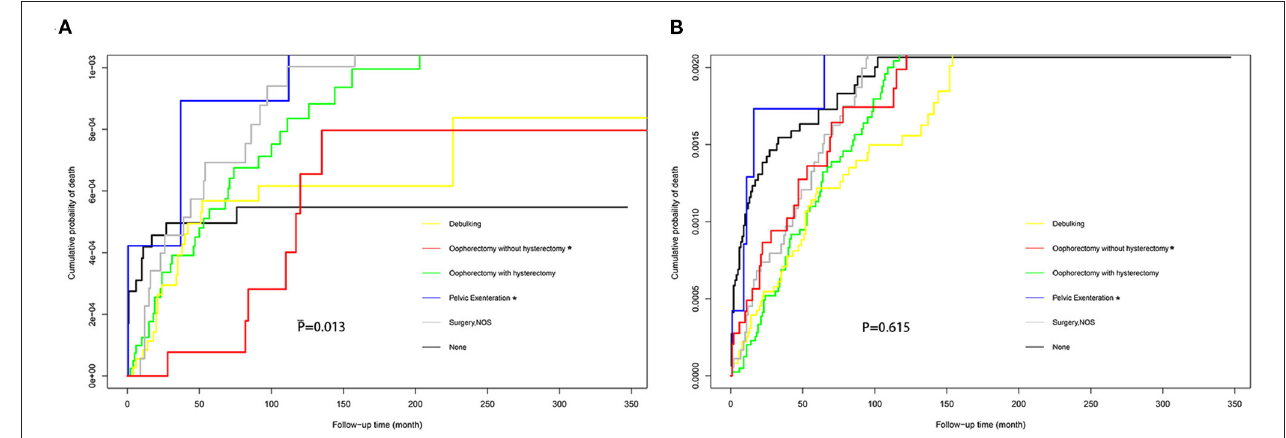
FIGURE 5 | Cumulative probability of suicide (A) and accidental death (B) in women with ovarian cancer who received different types of surgery.